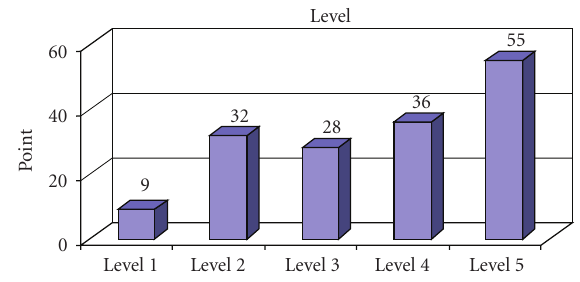
Figure 2: Care levels evaluated using